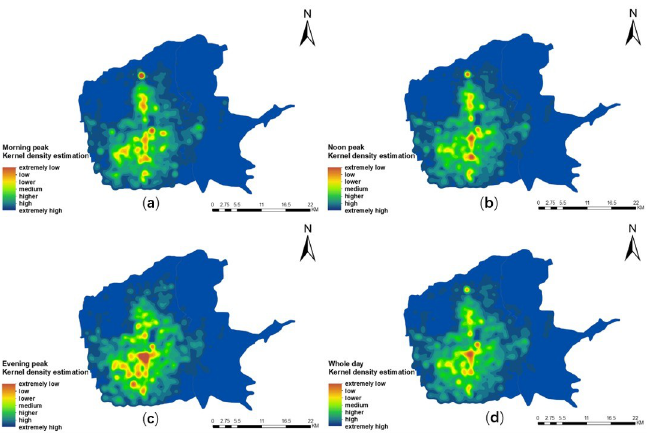
Fig 11. Spatial and temporal distribution characteristics of taxi travel demand on a single day off in the main urban area of Xi’an. (a) Morning peak; (b) noon peak; (c) evening peak; (d) overall peak.